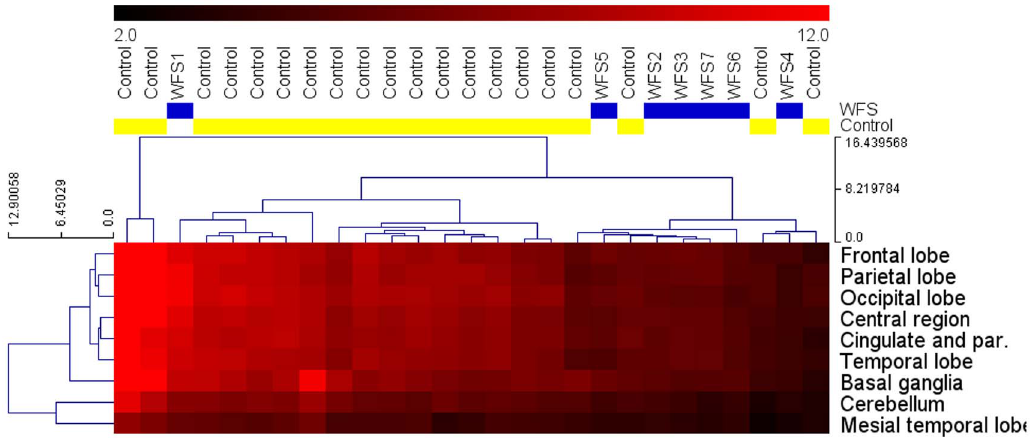
Fig. 1. Signal intensity profiles in particular areas of the brain based on hierarchical clustering analysis. The red bar above the chart represents SUV values observed in the examined